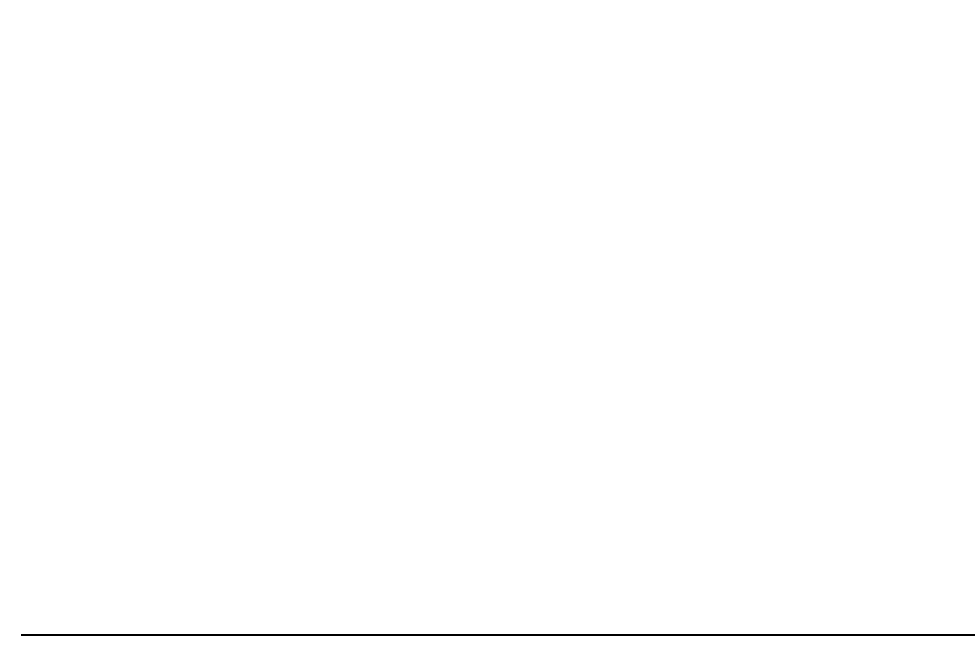
REGION : Volume 2, Number 1,